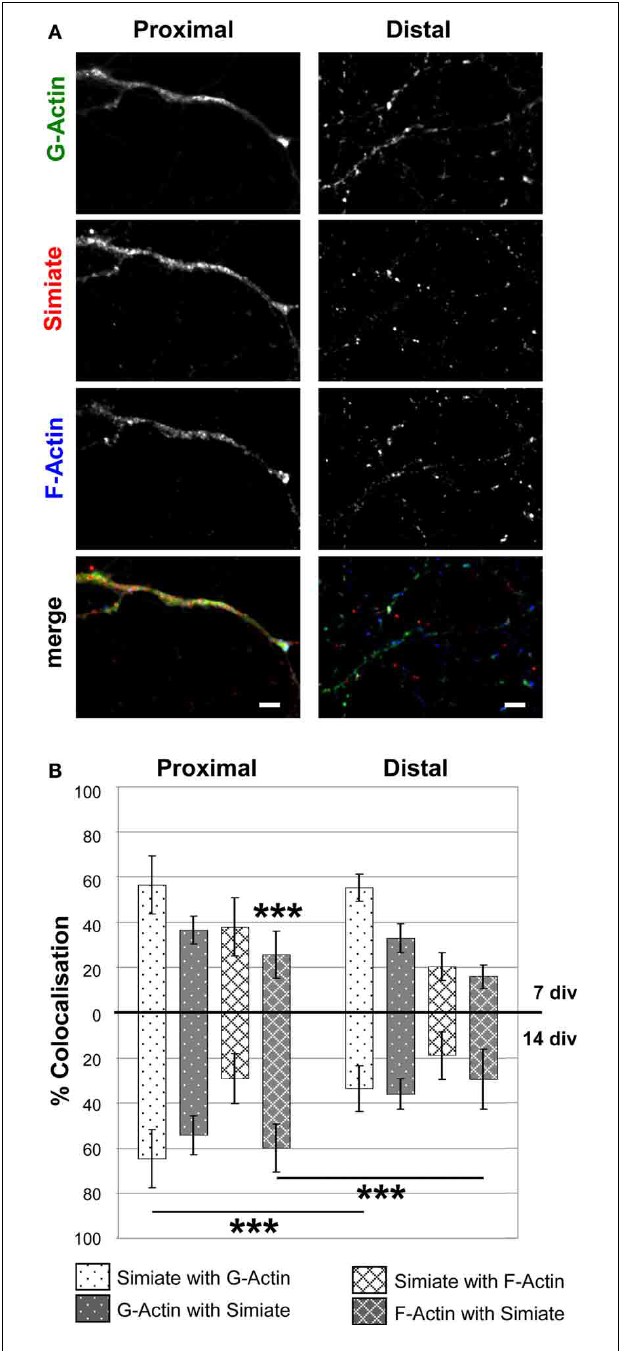
FIGURE 6 | Colocalization of Simiate with G- and F-Actin in proximal and distal dendrites. (A) Simiate shows a higher colocalization with G- and F-Actin in proximal dendrites than in distal dendrites of 14 div neurons from primary hippocampal cells. Scale bar: 5 μ m. Please see Figure 5 for further details. (B) Quantification of the percental colocalization as also shown in Figure 5B . Each of the eight 7 div colocalizations are significantly different compared to the respective 7 div data for growth cones shown in Figure 5B . For 14 div, this holds true only for the colocalization between Simiate with G-Actin. For the sake of clarity, significant differences between proximal or distal dendrites and growth cones are not graphically represented, but explained in detail in the results